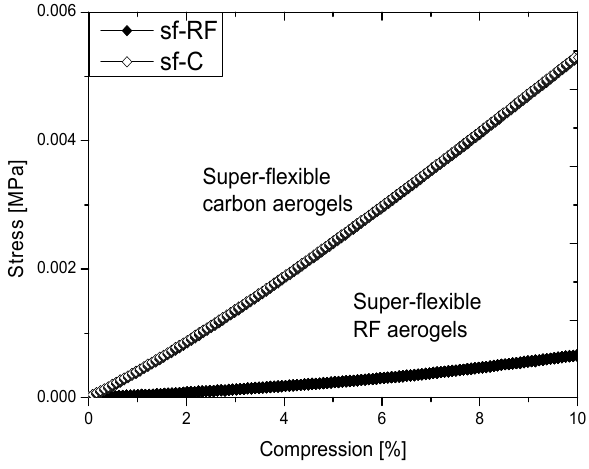
Figure 6. Compression curves of super-flexible aerogels.